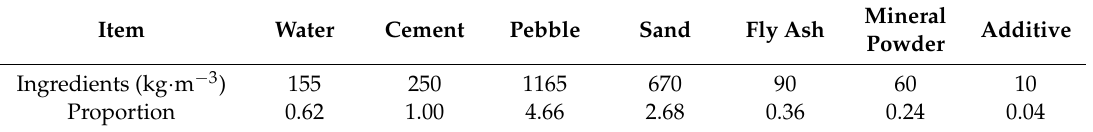
Table 1. Mixing Proportions of the Concrete Specimens.